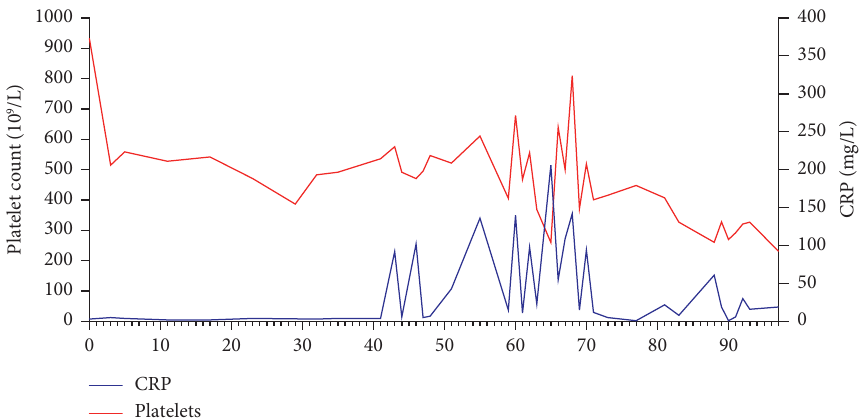
Figure 1: Trombocyte levels (red line) and C-reactive protein (CRP) (blue line) during the disease course. It also illustrates the un- complicated levels during the frst 40months, progressing into spiking levels as the clinical course changes and turns more complicated.